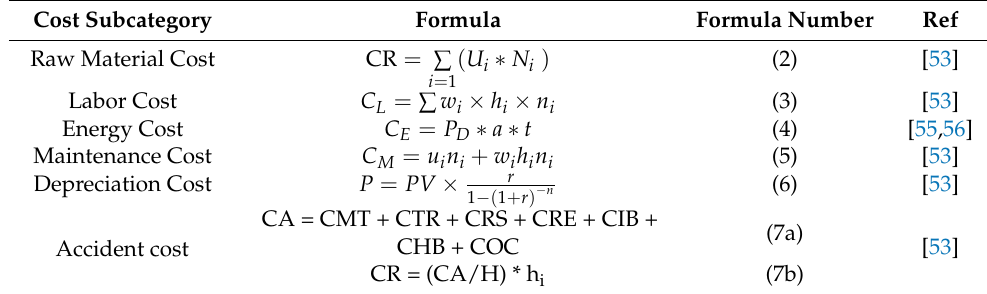
Table 1. Overview of costs and their